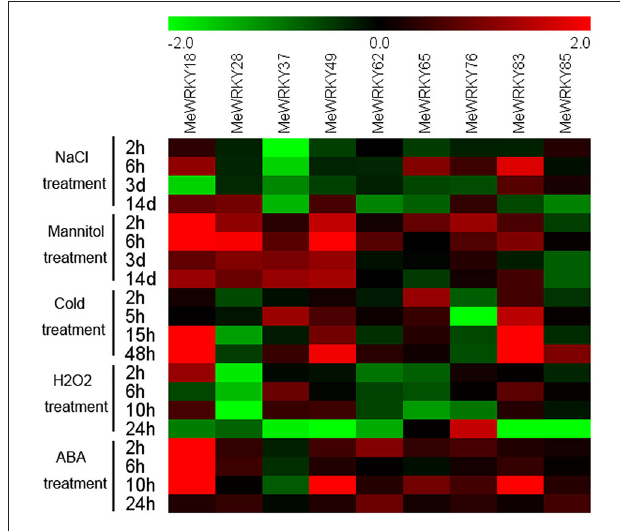
FIGURE 11 | Expression profiles of MeWRKY genes in leaves under various stresses and ABA treatments. Log2 based values from three replicates of qRT-PCR data were used to create the heatmap. The scale represents the relative signal intensity values. Relative expression values for each gene after various treatments are provided in Figures 6 – 10 and Table S6